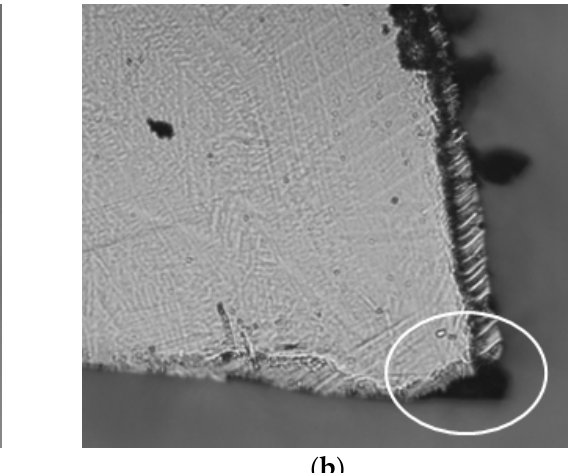
Figure 3. The radii of cutting edges determined from tooth images from both analysed saw blades: new saw blade ( a ) and sharpened saw blade ( b ).